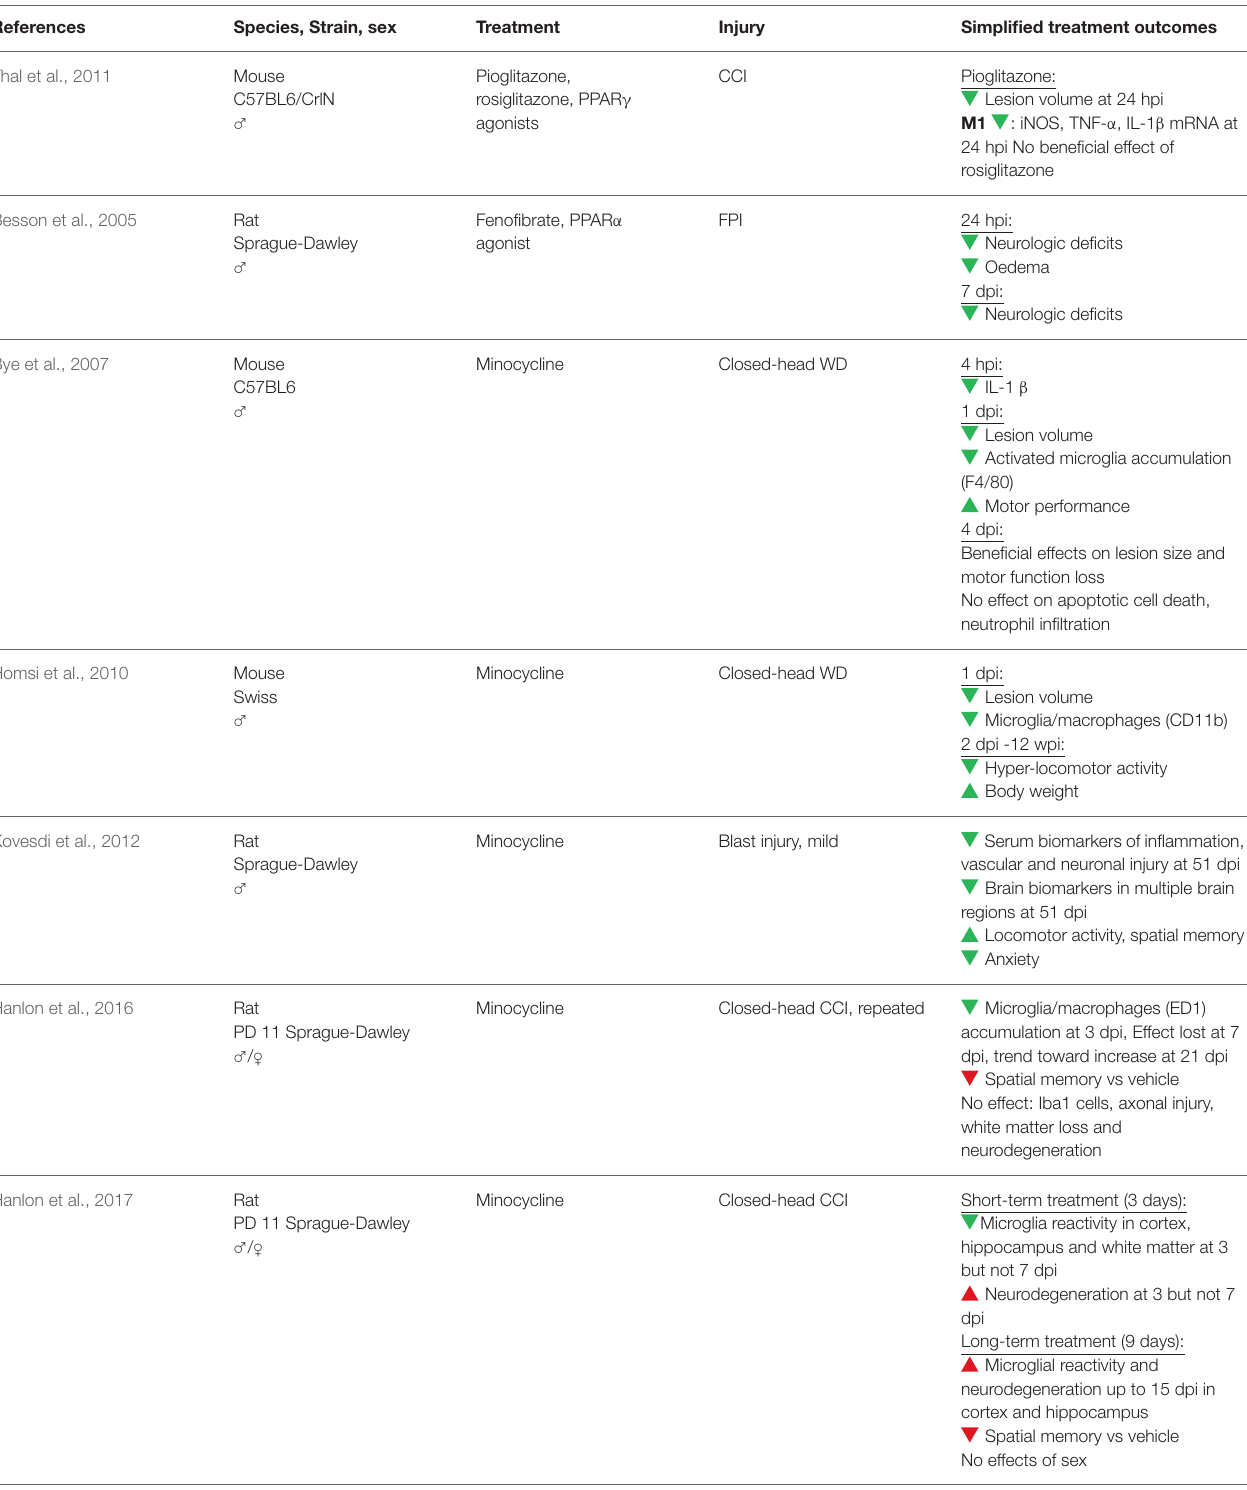
TABLE 2 | Treatments in experimental models of TBI targeting inflammation and